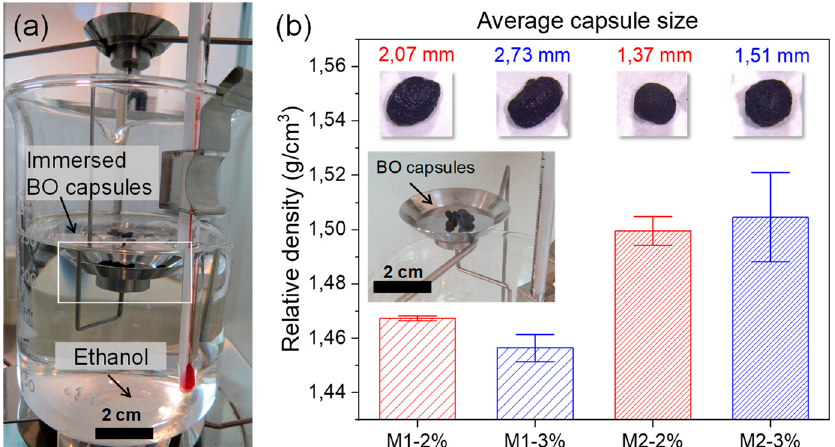
Figure 6. ( a ) Measurement of the relative density of the BO capsules with test method B of the ASTM D792-13 [22] used in the case of materials with densities that are very close to, or lighter than, water. In the image, the mass in air of a 100 mg sample BO of capsules was determined, and then it was immersed in ethanol with density 0.789 g / cm 3 , determining its apparent mass upon immersion and calculating its relative density; ( b ) average results of density of BO capsules with St. Dev. error bars.